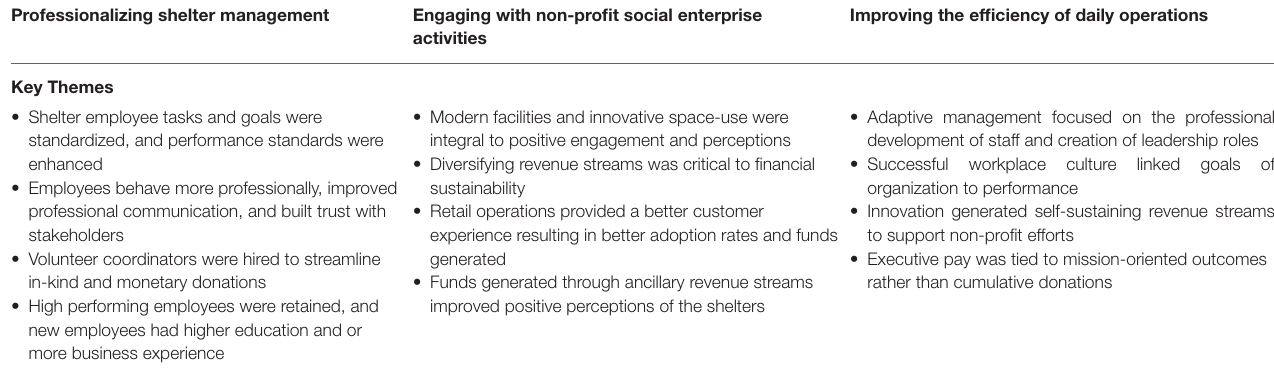
TABLE 1 | Overview of three key themes and related